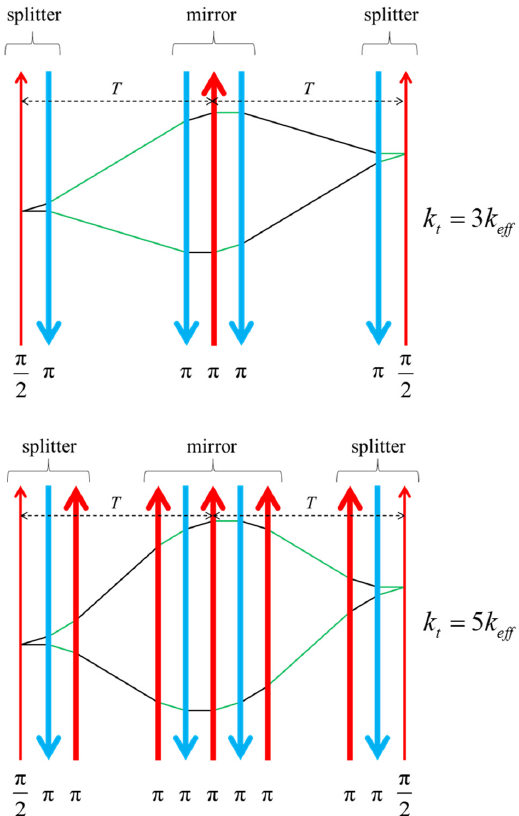
Figure 7. Large momentum transfer by additional π − pulses in alternating directions. Each Raman pulse here is a pair of counterproparating Raman beams. The arrows show the effective directions of Raman pulses.